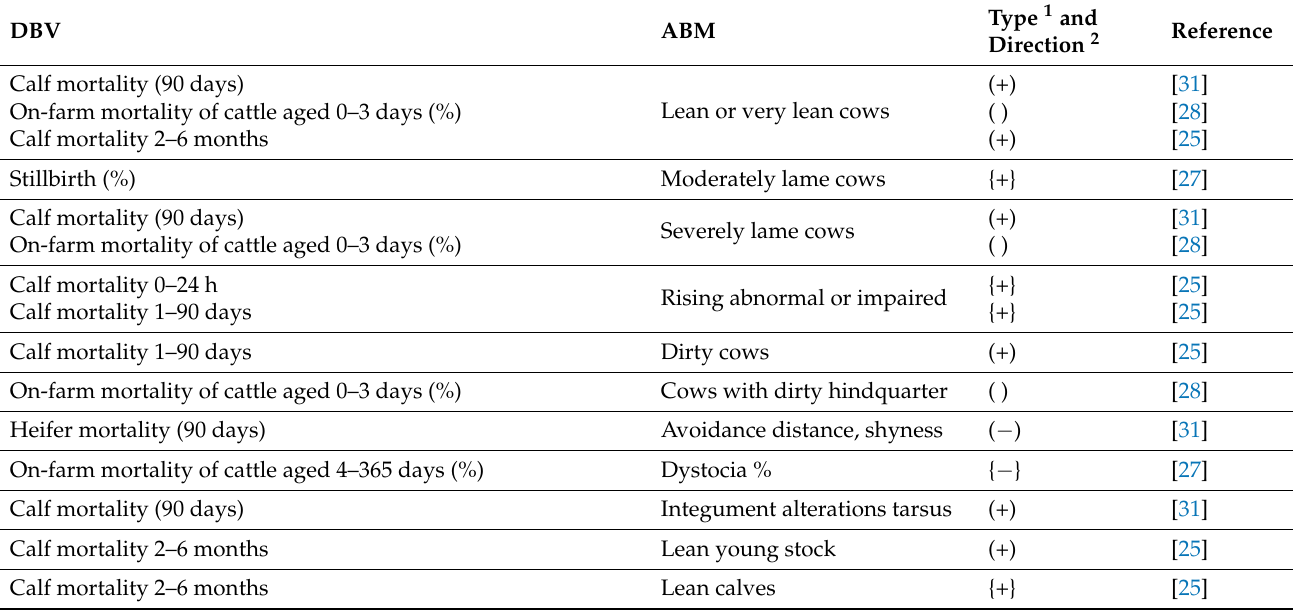
Table 5. Associations between data-based variables (DBVs) related to calf mortality and animal-based measurements (ABMs) extracted from four scientific